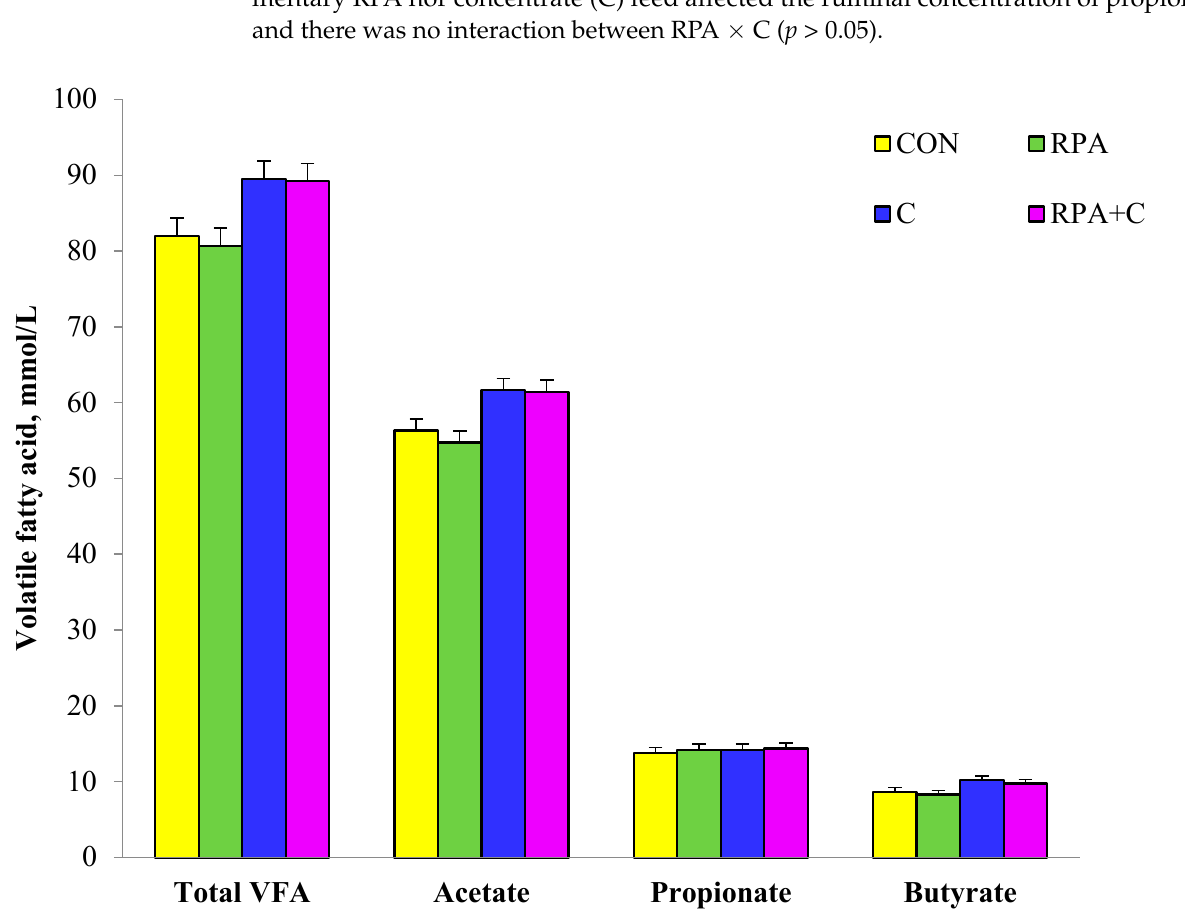
Figure 1. Rumen fermentation parameters of grazing, lactating yaks offered supplementary 15 g/day RP-Lys and 5 g/day RP-Met (RPA), 1.2 kg/day concentrate (C) and 15 g/day RP-Lys, 5 g/day RP-Met and 1.2 kg/day concentrate (RPA+C), or no supplement (controls-CON). Values are means ± Standard Error of Mean (SEM); n = 6 for each group. p values for: Volatile fatty acids (VFAs) for RPA, C, and RPA × C were 0.734, <0.01, and 0.828, respectively; acetate values for RPA, C, and RPA × C were 0.773, <0.01, and 0.923, respectively; propionate values for RPA, C, and RPA × C were 0.743, 0.680, and 0.823, respectively; and butyrate values for RPA, C, and RPA × C were 0.469, 0.022, and 0.957, respectively.